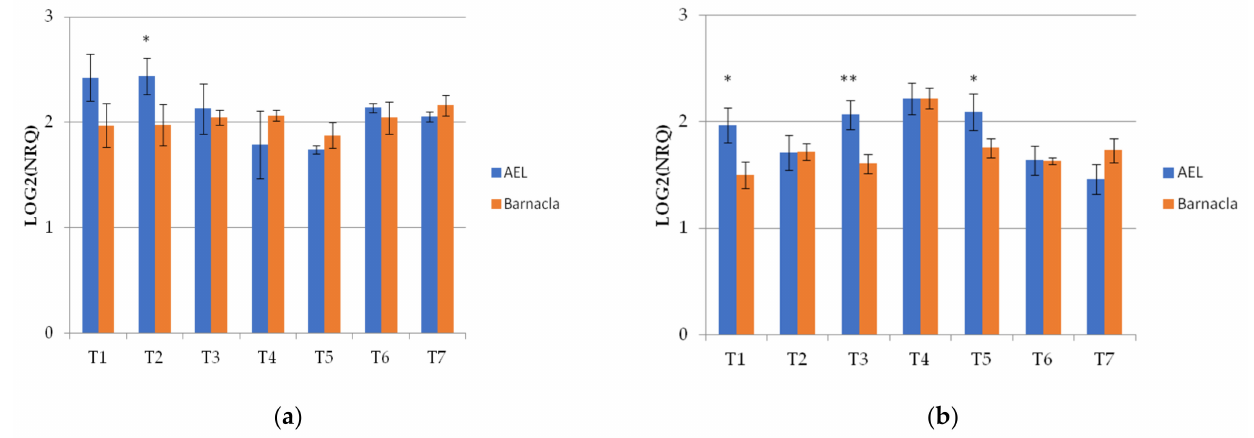
Figure 3. The expression profiles of Wdhn13 gene transcript in the two genotypes measured under FI and RI conditions. ( a ) The expression profiles of Wdhn13 transcript in AEL and Barnacla observed under FI condition. ( b ) The expression profiles of Wdhn13 transcript in AEL and Barnacla observed under RI condition. Data are represented as mean ± SE. Significance codes: ** p < 0.01, * p < 0.05.